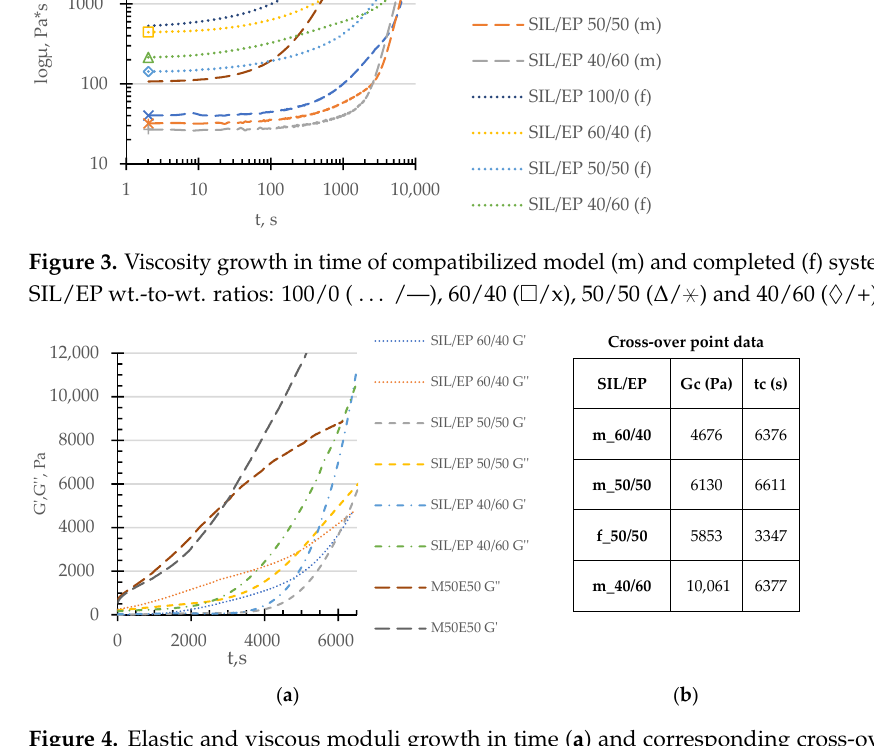
Figure 4. Elastic and viscous moduli growth in time ( a ) and corresponding cross-over point data ( b ) of completed (f) and compatibilized model (m) systems, following SIL/EP wt.-to-wt. ratios: 60/40 (dot dashed line), 50/50 (dashed line) and 40/60 (dotted line).